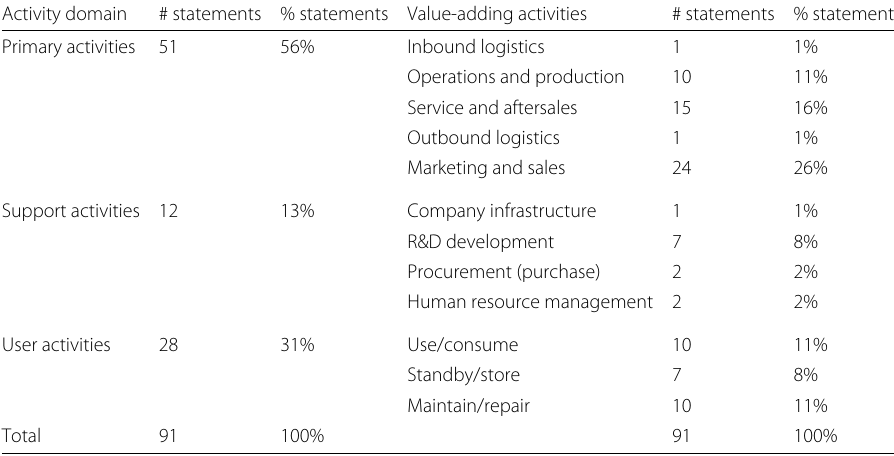
Table 9 Assignment of statements from open-ended question on motivators and expected added value of IoT application development to value-chain activities